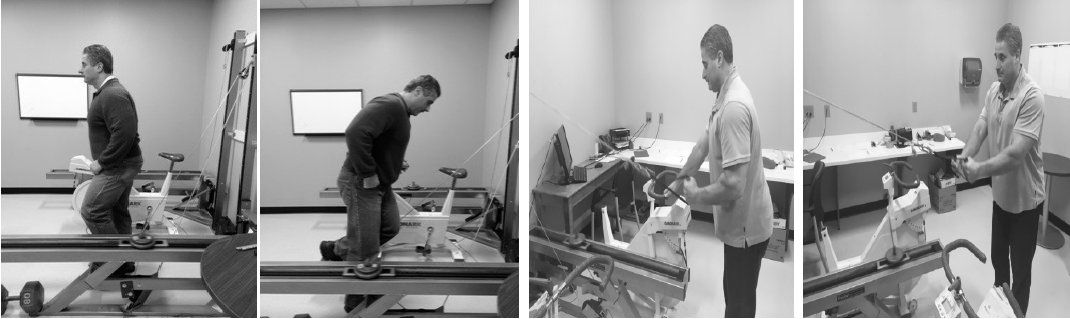
Figure 2. The four movements (standing knee extension, standing hip extension, unilateral row, bilateral pulldown) performed on the IET.